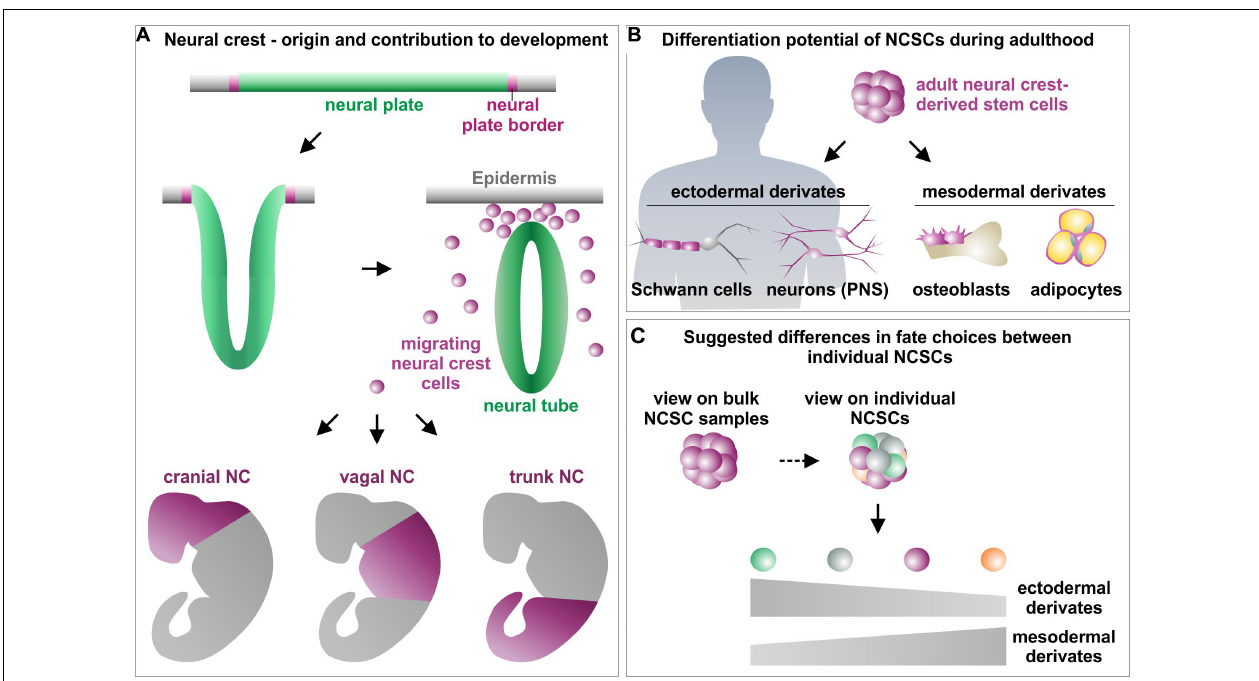
FIGURE 3 | Schematic view on the role of neural crest stem cells in embryogenesis (A) and adulthood (B) as well as suggested differences between favored fate choices of single NCSCs (C) . (A) Modified from Greiner et al. (2019a) and Srinivasan and Toh (2019), NC, Neural crest; NCSCs, Neural crest-derived stem cells; PNS, Peripheral nervous